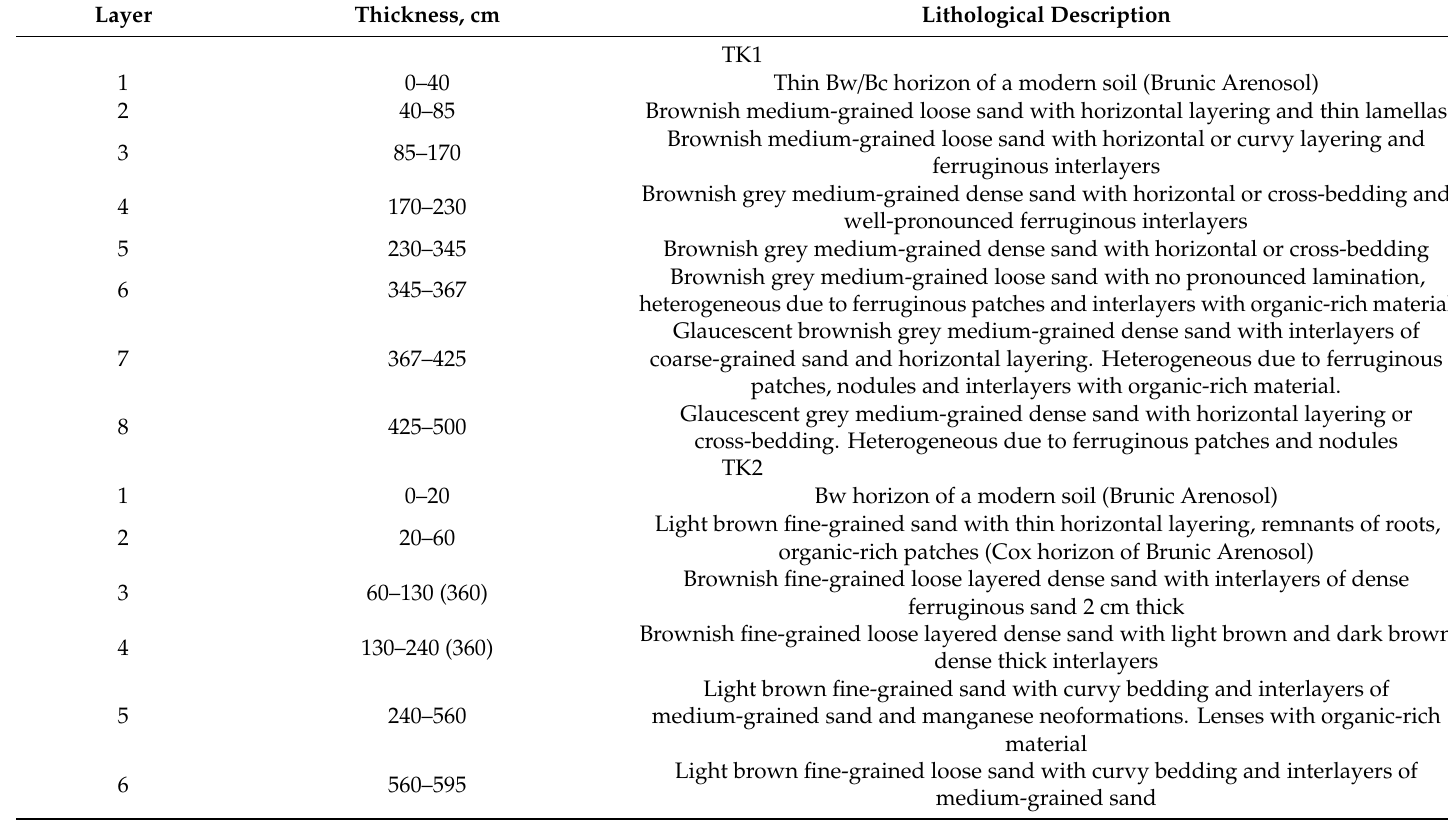
Table A1. Brief lithological characteristic of studied